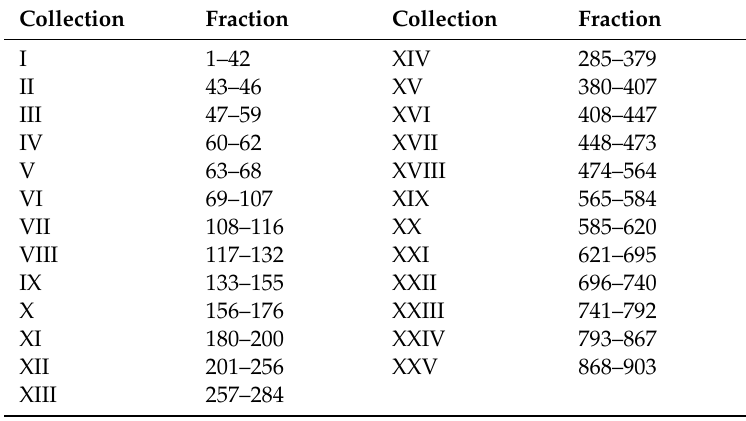
Table 2. Fraction collections from Hibiscus sabdari ff a calyx acetonic extract classified according to thin-layer